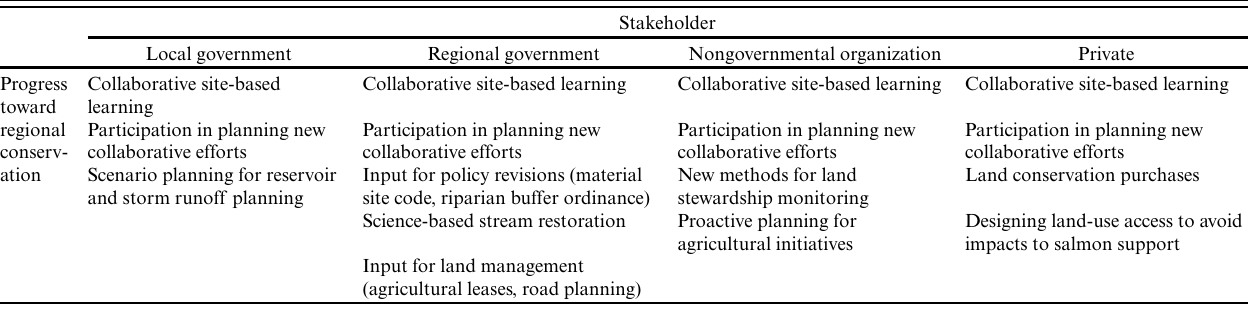
Table 2. Examples of outcomes leading to progress toward regional conservation efforts from the State of Alaska Salmon and People Kenai Lowlands Workgroup effort.